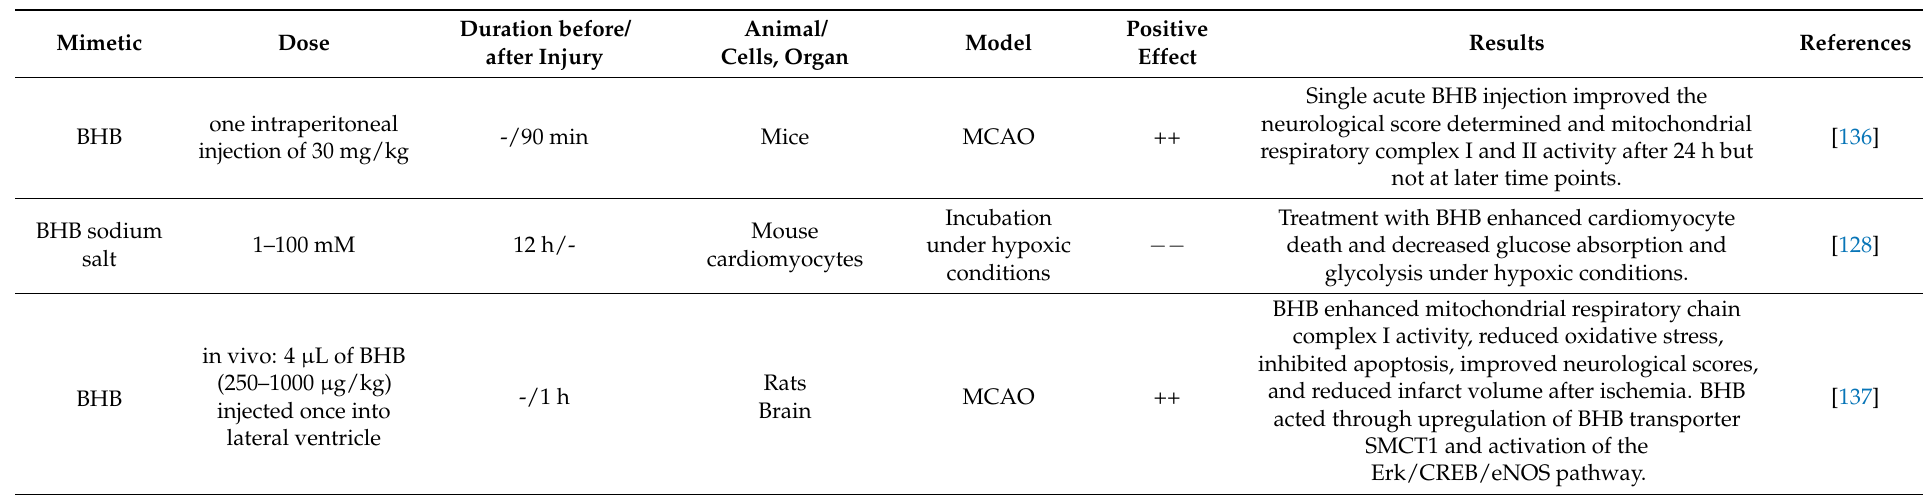
Table 2. Studies related to the usage of KD mimetics against IR